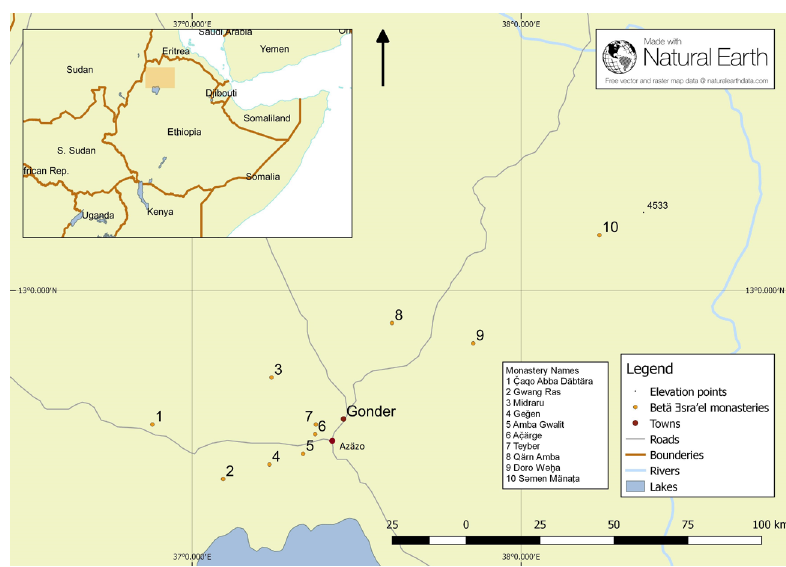
Estimated location of Beta Israel monasteries. Made with Natural Earth (Free vector and raster map data @